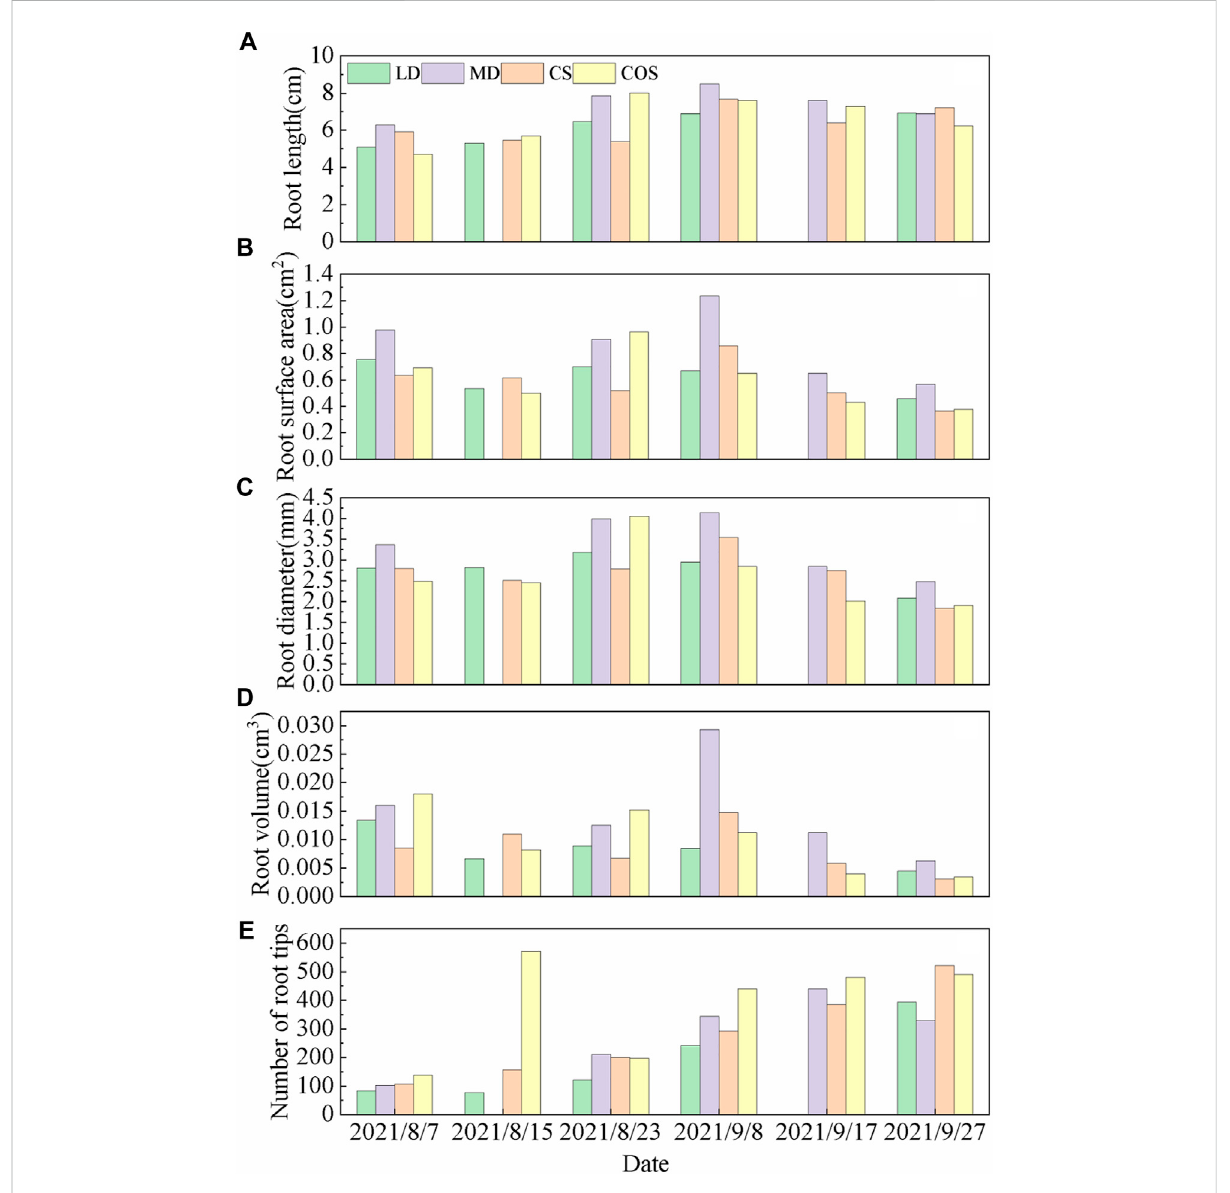
FIGURE 5 Dynamic changes of root morphological parameters of summer maize under different drought conditions. (A – E) are the dynamic changes of root length, root surface area, root diameter, root volume and number of root tips, respectively. (since only drought and post drought rehydration experiments were conducted, the middle drought group on 8/15 and the light drought group on 9/17 was not measured. The unmeasured data did not affect the experimental